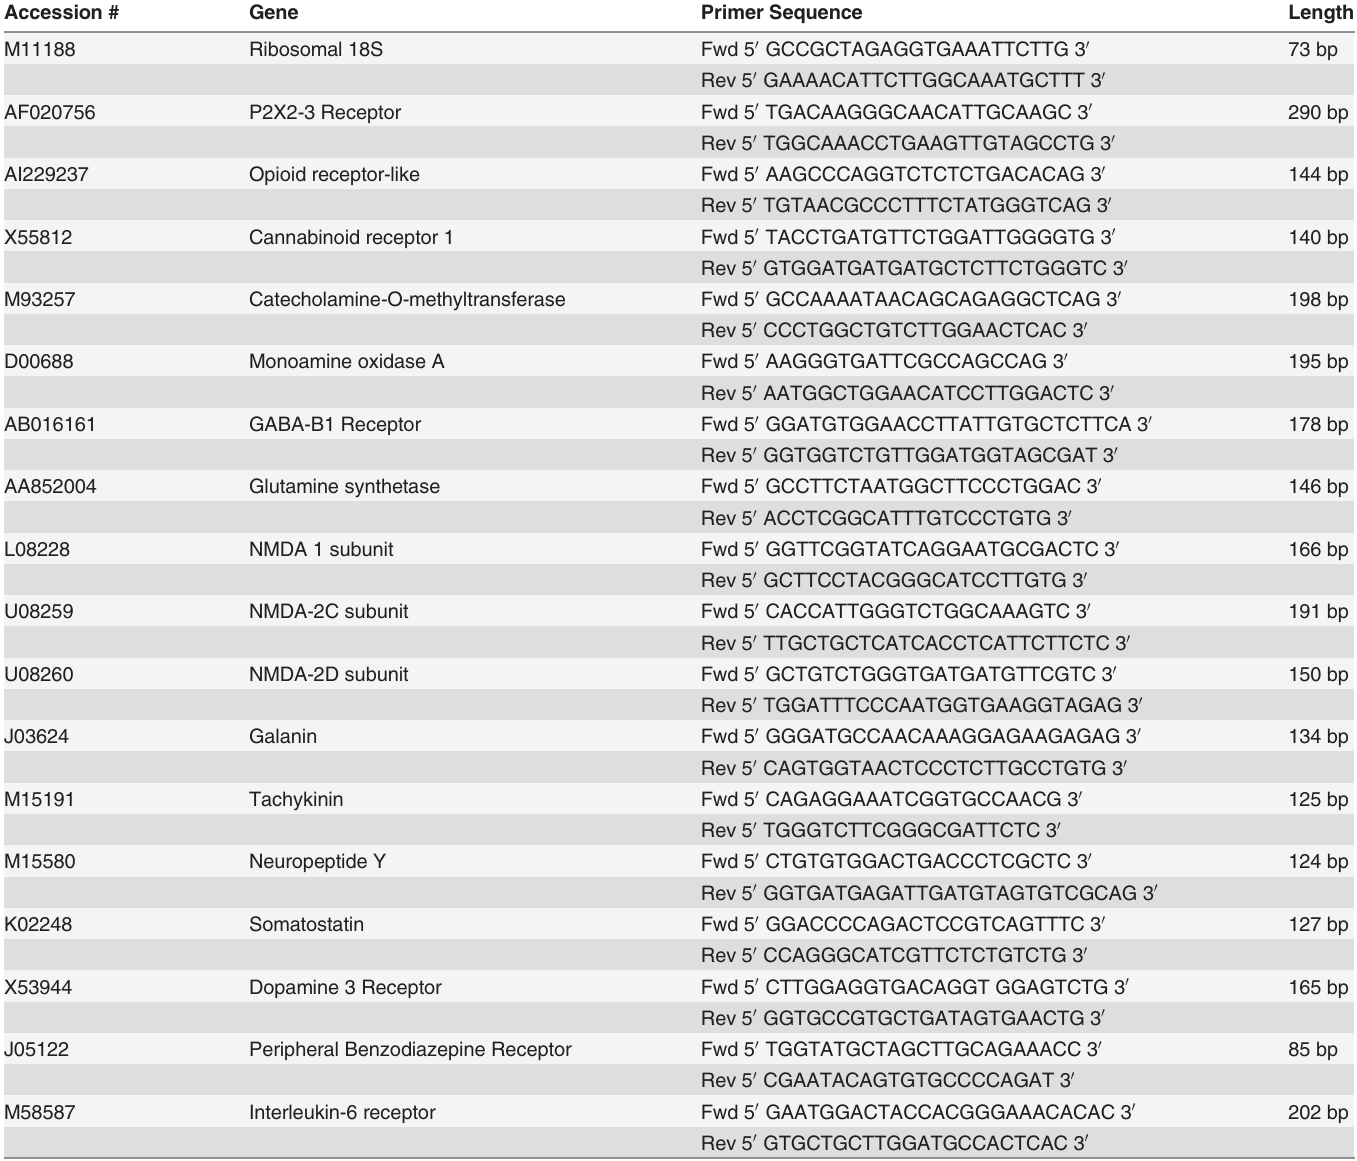
Table 1. Primer sequences for the genes examined using real time